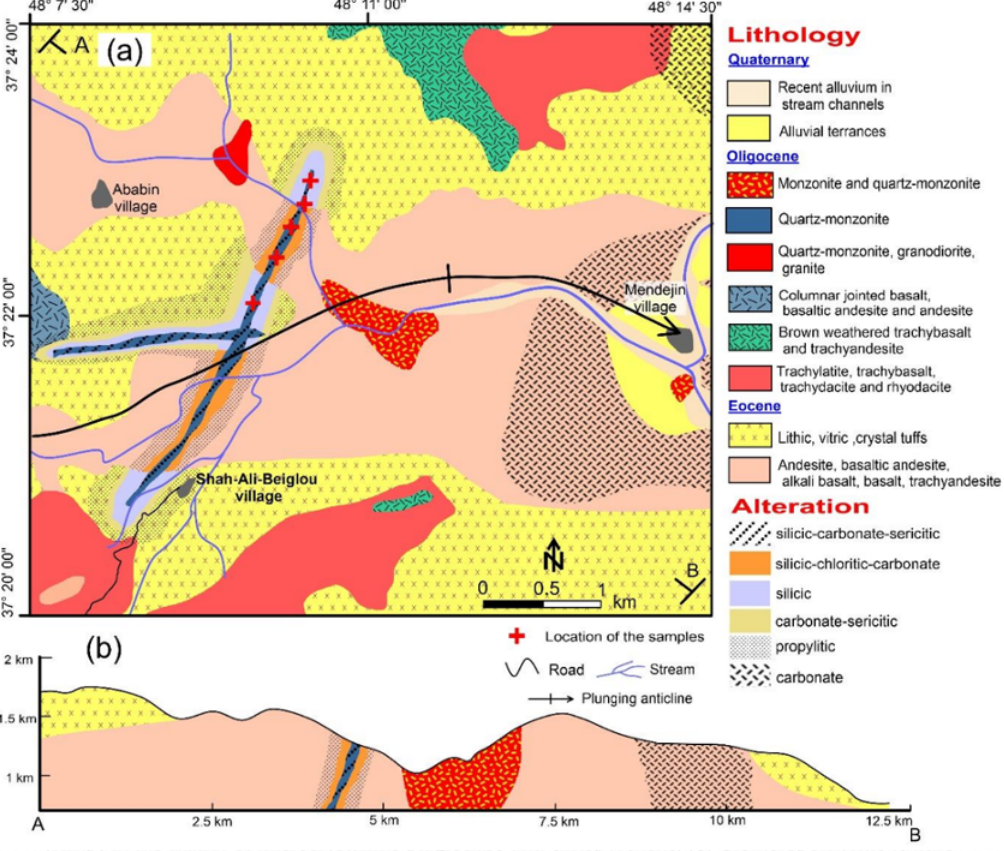
Figure 3. ( a ) Geological map of the Shah-Ali-Beiglou showing the rock units and ore-bearing veins, revised and modified based on the new field data from 1:100,000 geological map of Hashjin provided by Geological Survey of Iran; ( b ) Schematic cross-sections showing ore-bearing vein at the contact of andesite-basalt lavas. Reproduced with permission from Faridi and Anvari [50], published by Geological Survey of Iran,